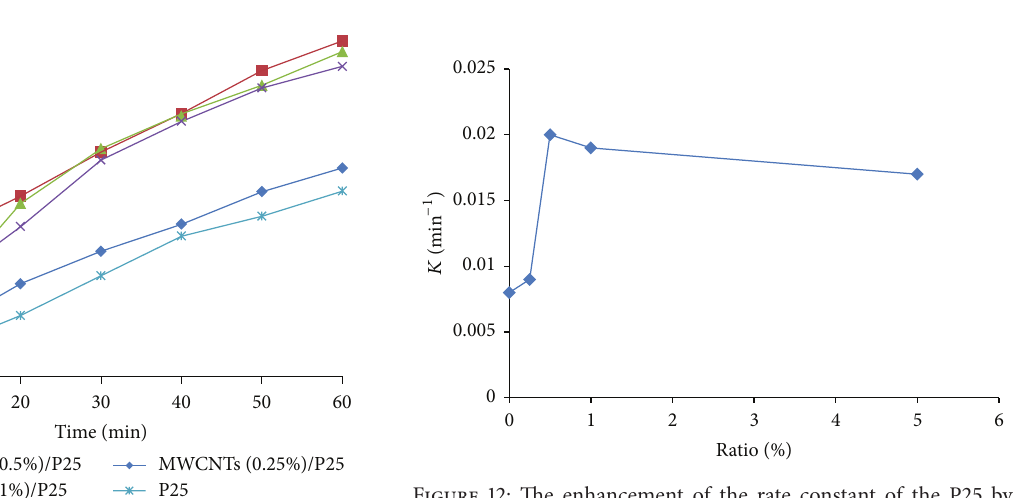
Figure 12: The enhancement of the rate constant of the P25 by MWCNTs with different